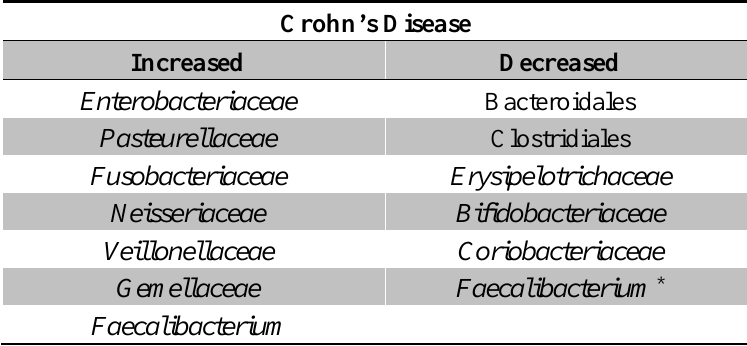
Table 1. Description of mucosal microbiota changes found in treatment-naive Crohn’s disease [65,66]. Several bacterial taxa are increased or decreased compared to non-IBD controls. * Changes in Faecalibacterium were inconsistent across studies, with one study reporting an increase and the other a